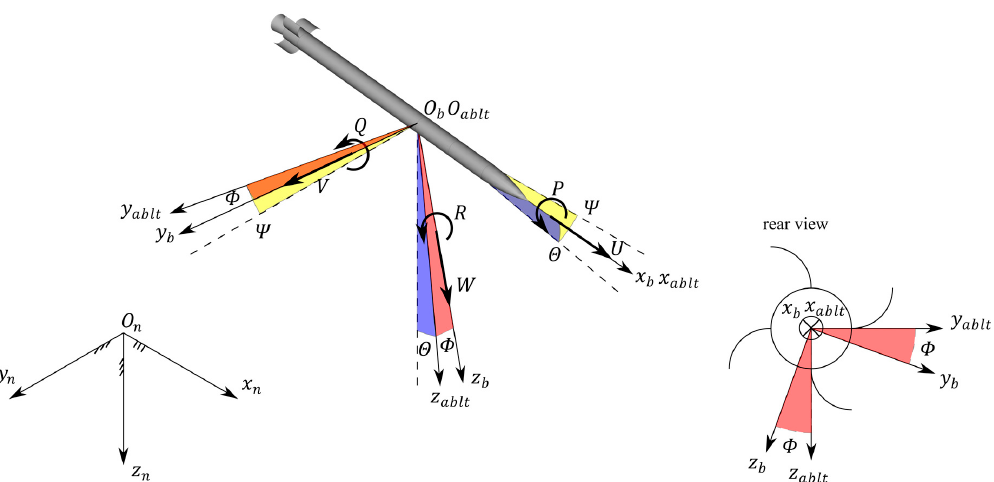
Figure 2. Coordinate systems used in the model.